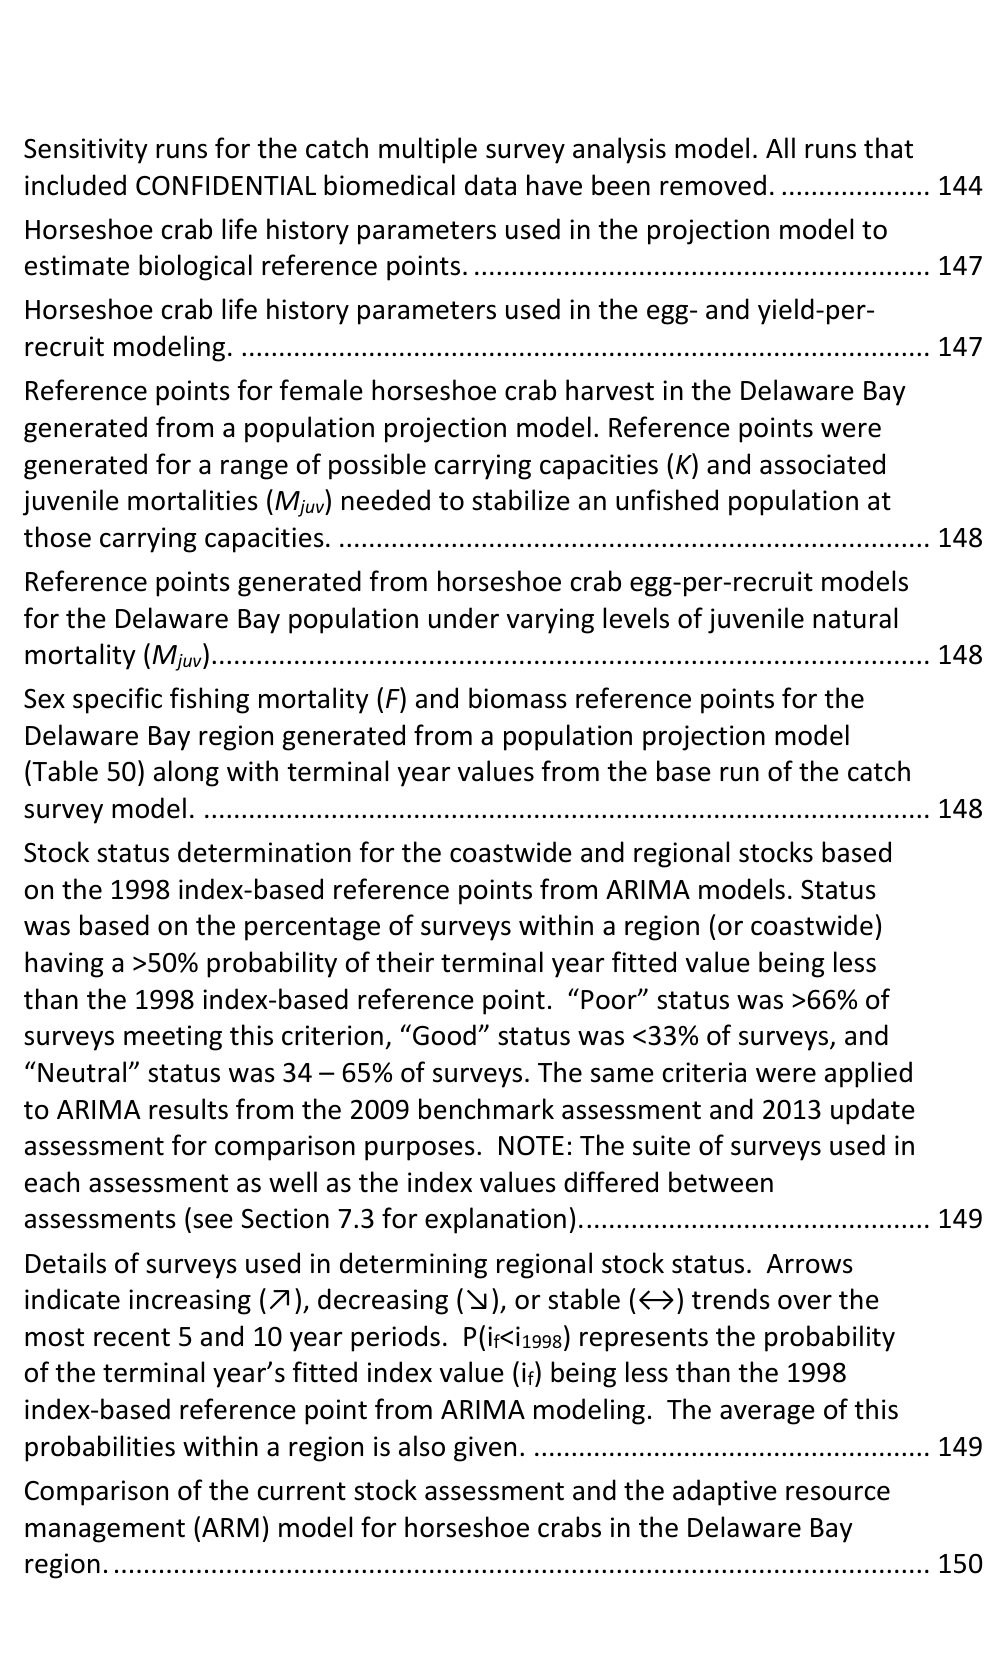
2019 Horseshoe Crab Benchmark Stock Assessment Non-Confidential Report